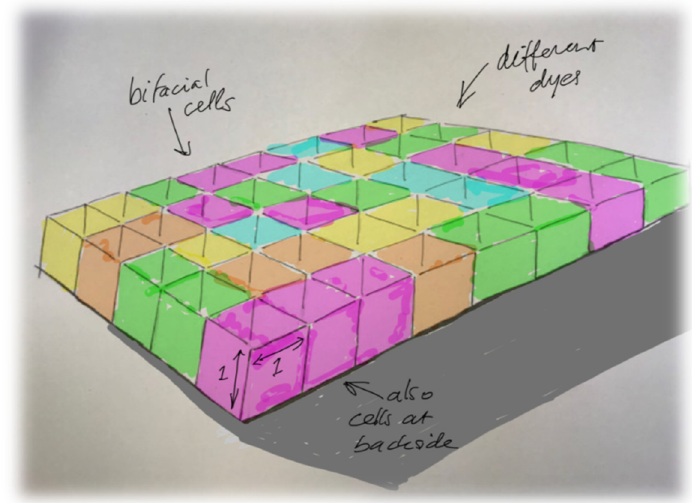
Figure 2. A sketch of a bifacial LSC PV mini-module for building-integrated PV (BIPV) applications by Ned Ekins-Daukes and Angèle Reinders, made during the Exciton Solar + Design Summer School at the University of New South Wales (UNSW), Sydney, 2019.